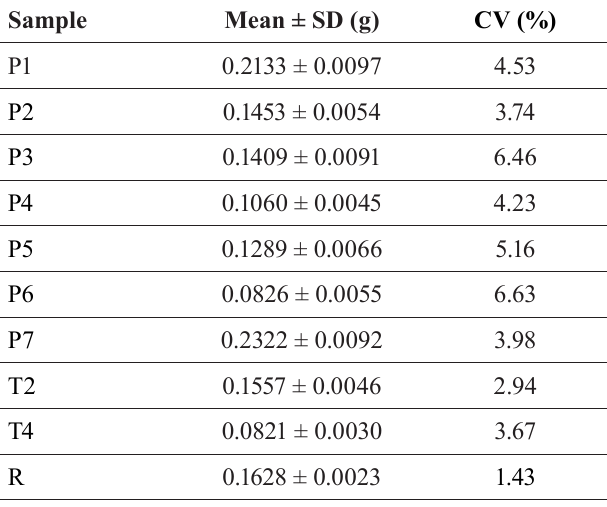
TABLE III - Mean weight calculated for all studied batches